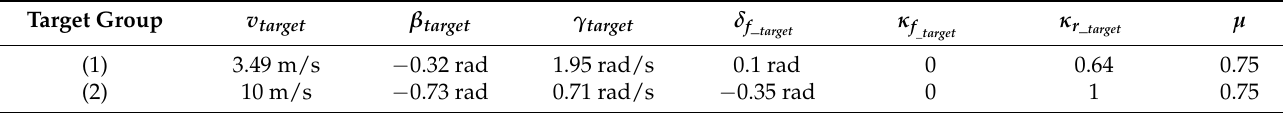
Table 2. Target drifting motion groups.